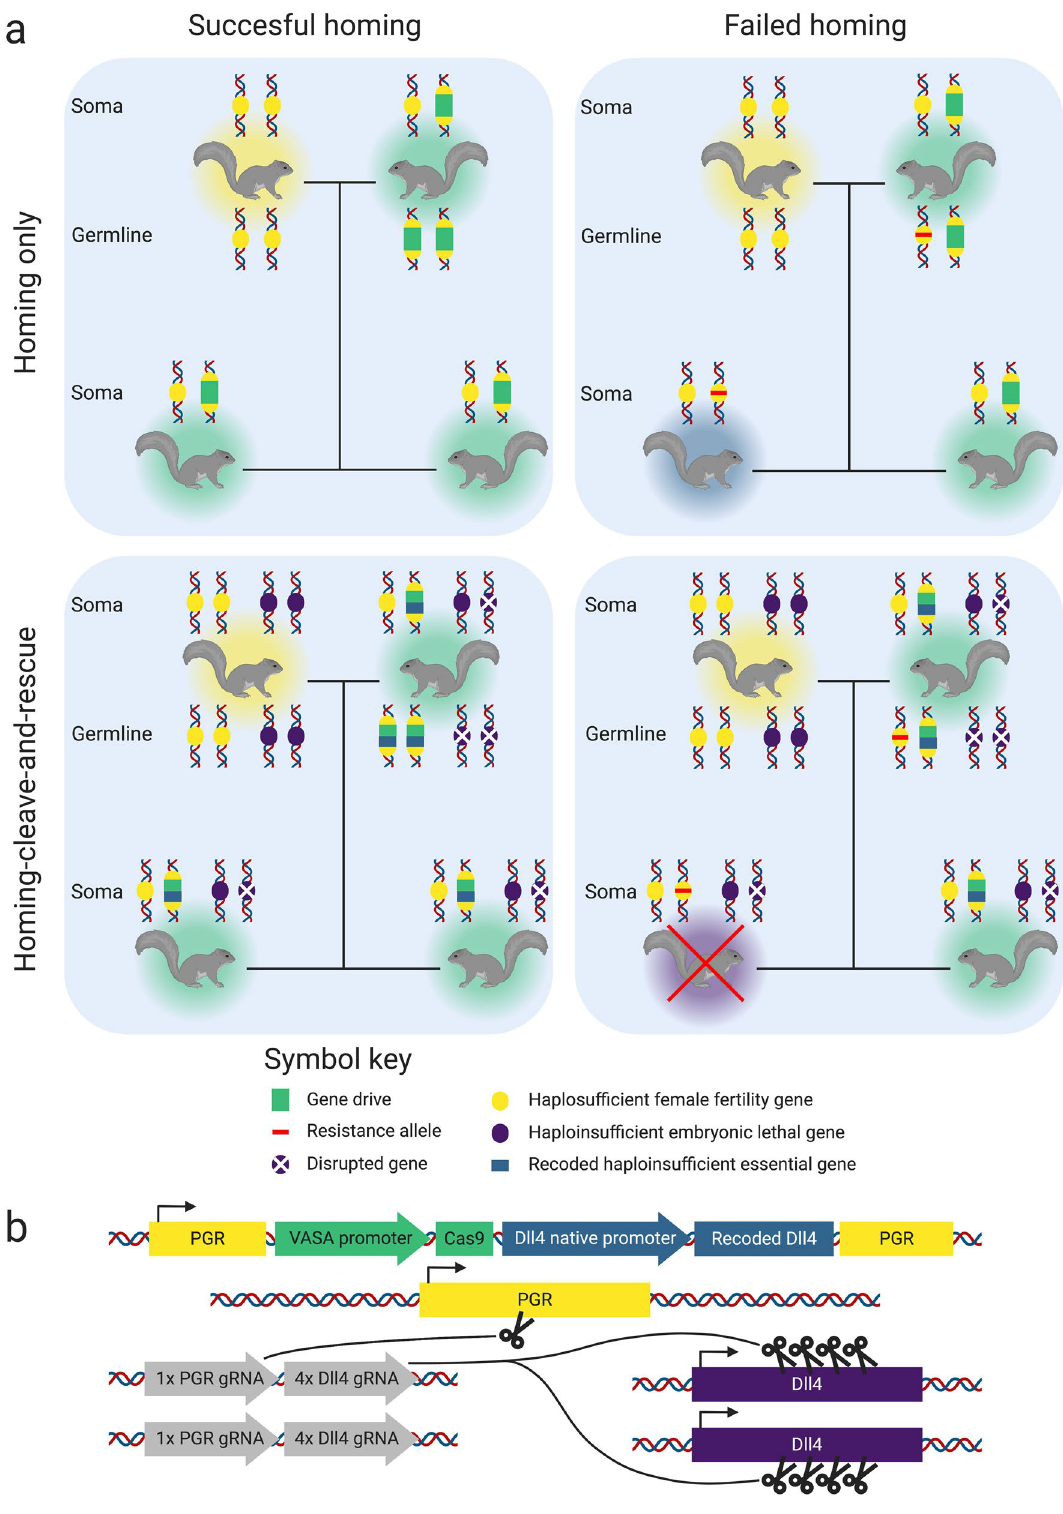
Figure 2. ( a ) A comparison of the inheritance scenarios of a homing-only gene drive (top row) and a homing- cleave-and-rescue gene drive (bottom row). The two panels in the left column show inheritance when homing is successful, and the two panels on the right show inheritance when homing fails. Each panel shows two parent squirrels and two offspring, each with the loci relevant for the gene drive. A legend for the gene drive components is provided. Squirrels colour coded halos represent their genotype: yellow = wildtype, turquoise = gene drive, blue = resistant, and purple = non-viable. ( b ) A potential HD-ClvR construct for grey squirrel. Colour coding is consistent with ( a ) and additionally, gRNAs are shown in grey. The gRNAs shown in this figure constitute one daisy element, multiple of these would constitute a